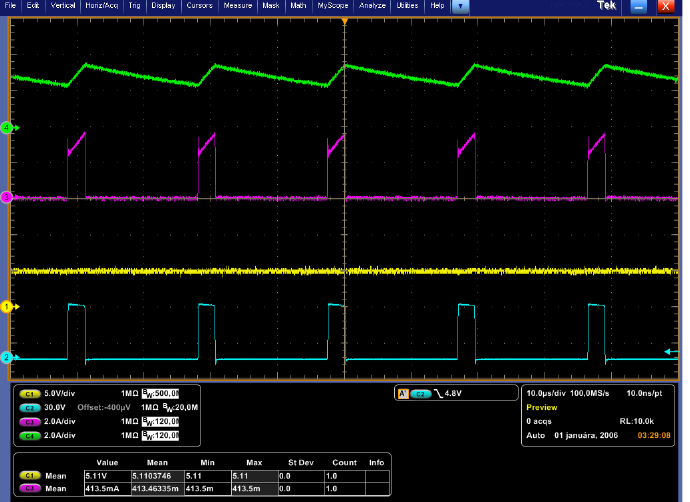
Figure 13. The example of a steady state measurement; Channel 1 (yellow) presents “ V Load ” , Channel 2 (cyan) presents “ V reg-out ” , Channel 3 (purple) presents Isw, and Channel 4 (green) presents I L.